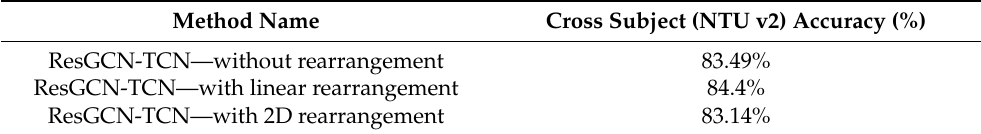
Table 2. Results that show how the rearrangement of the joints influences the performance of the proposed architectural